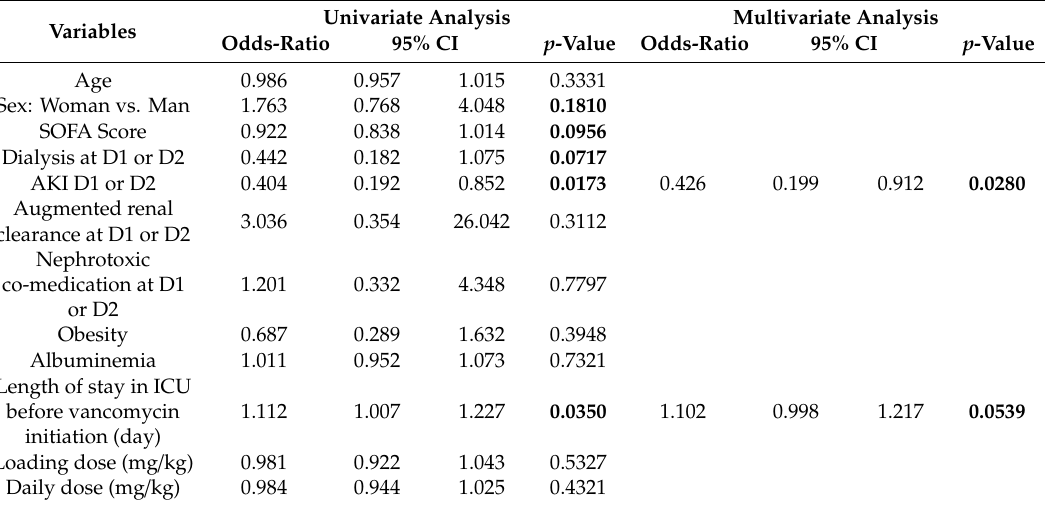
Table 5. Multivariate analysis for risk factors of being under the